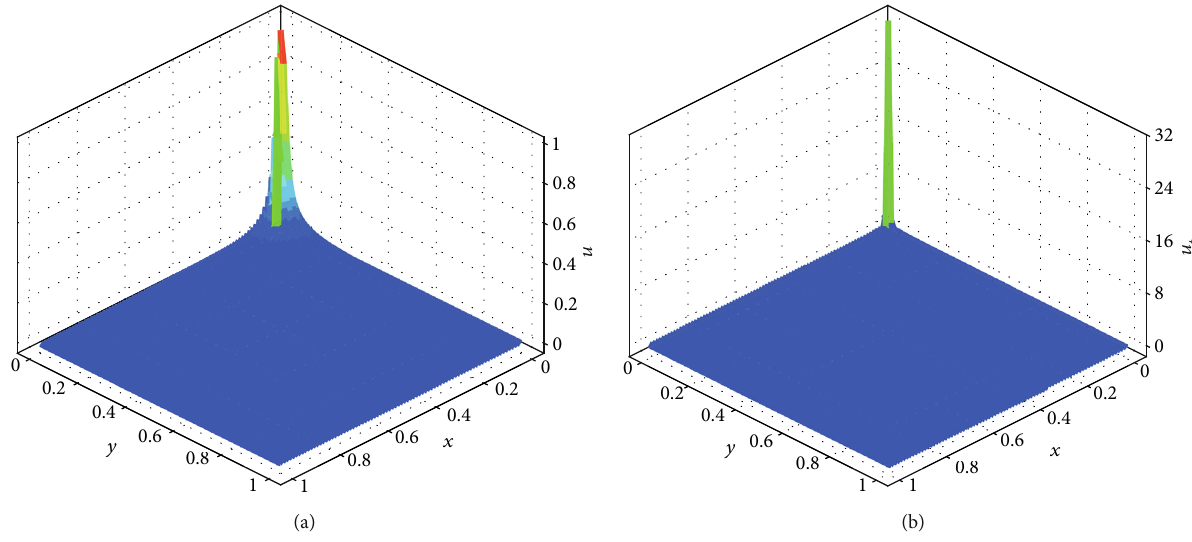
∗ and (b) the 3D plot of u 6